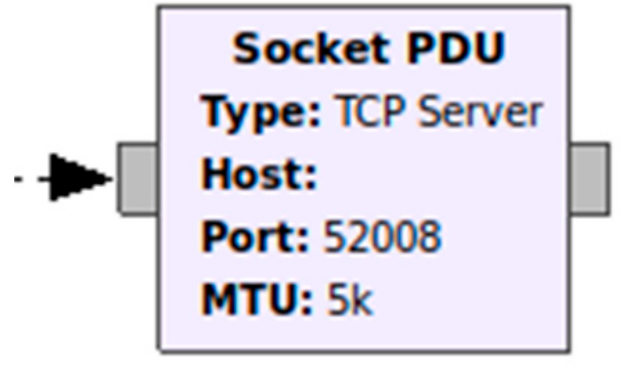
Figure 7. Data input block.